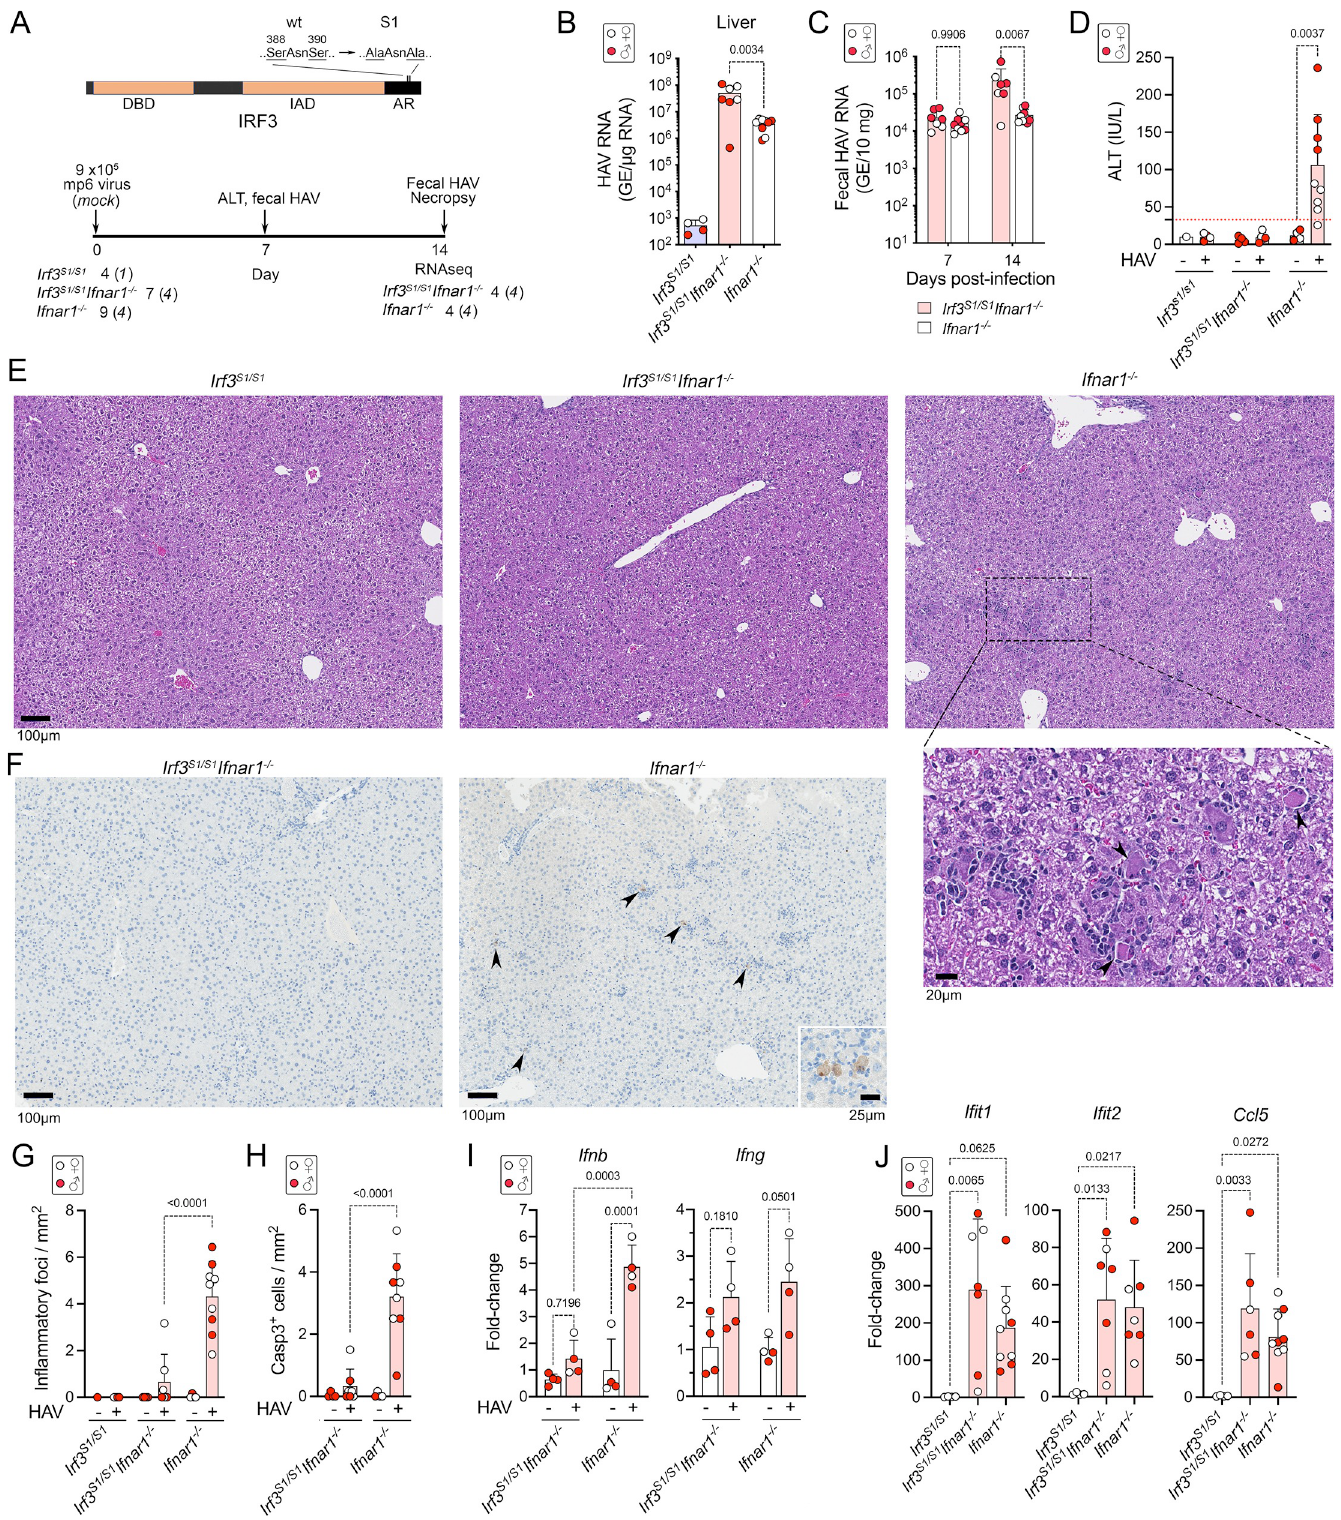
Fig 3. Infectious HAV challenge of Irf3 S1/S1 , Irf3 S1/S1 Ifnar1 -/- , and Ifnar1 -/- mice. (A) ( top ) IRF3 protein structure showing location of Ser-to-Ala substitutions in Irf3 S1/S1 mice that render the protein transcriptionally inactive. DBD, DNA-binding domain; IAD, IRF-association domain; AR, autoinhibitory region. ( bottom )